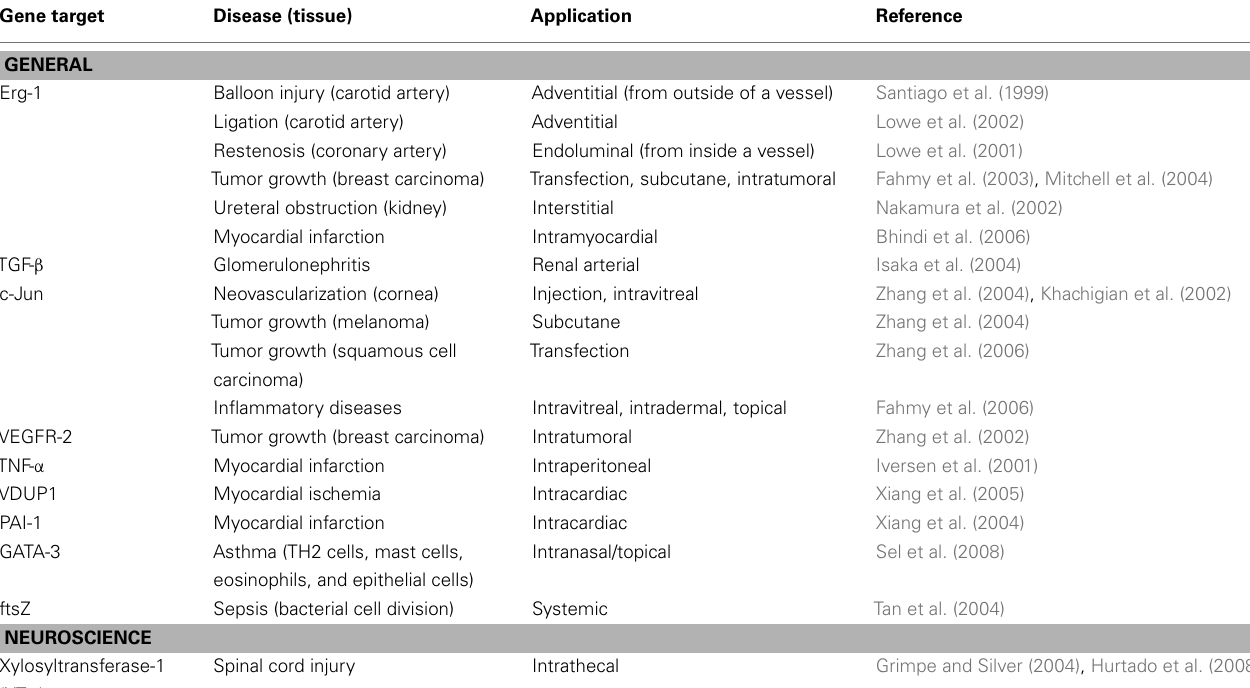
Table 1 | In vivo application of deoxyribozymes (modified from Isaka,